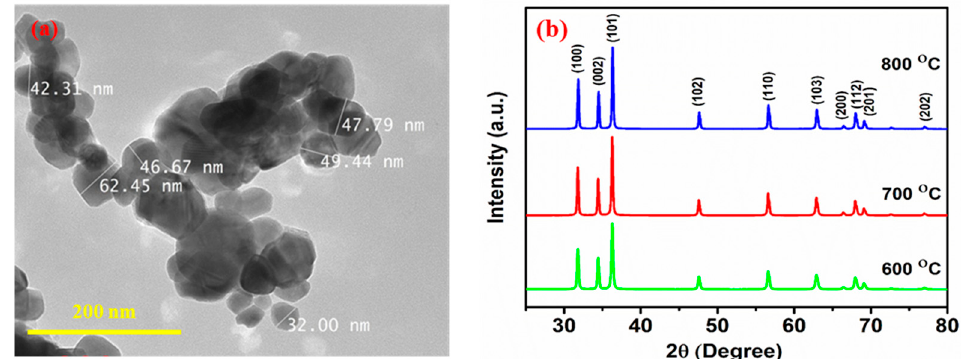
Figure 7. ( a ) TEM micrographs of ZnO nanoparticles synthesized at a constant applied potential of 16 kV, a distance between collector and nozzle of 12 cm, a flow rate of 1 mL/h, and a calcination temperature of 600 °C. ( b ) XRD patterns of ZnO nanoparticles synthesized at a constant applied potential of 16 kV; a distance between collector and nozzle of 12 cm; a flow rate of 1 mL/h; and calcination temperatures of 600 °C, 700 °C and 800 °C.